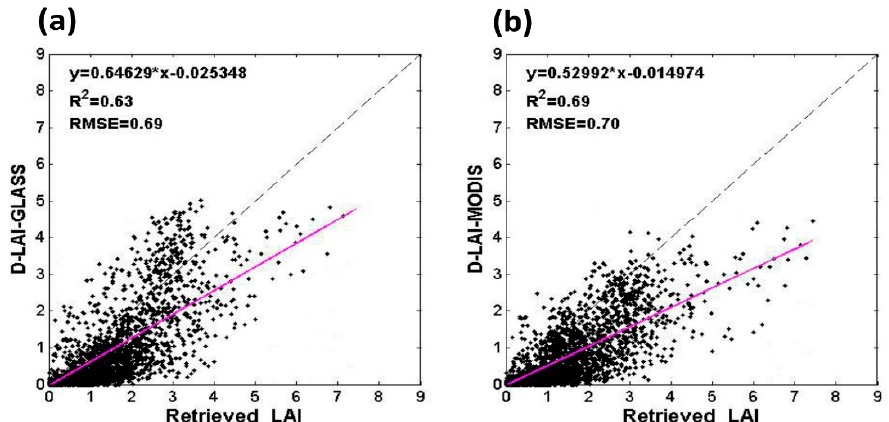
Figure 7. Validation of downscaled LAI against retrieved LAI in July 2012: ( a ) D_LAI_GLASS and retrieved LAI; ( b ) Comparison of D_LAI_MODIS and retrieved LAI. Retrieved LAI means high resolution (30 m) LAI retrieved by using an instantaneous quantitative model based on the law of energy conservation from Chinese HJ-1B data.